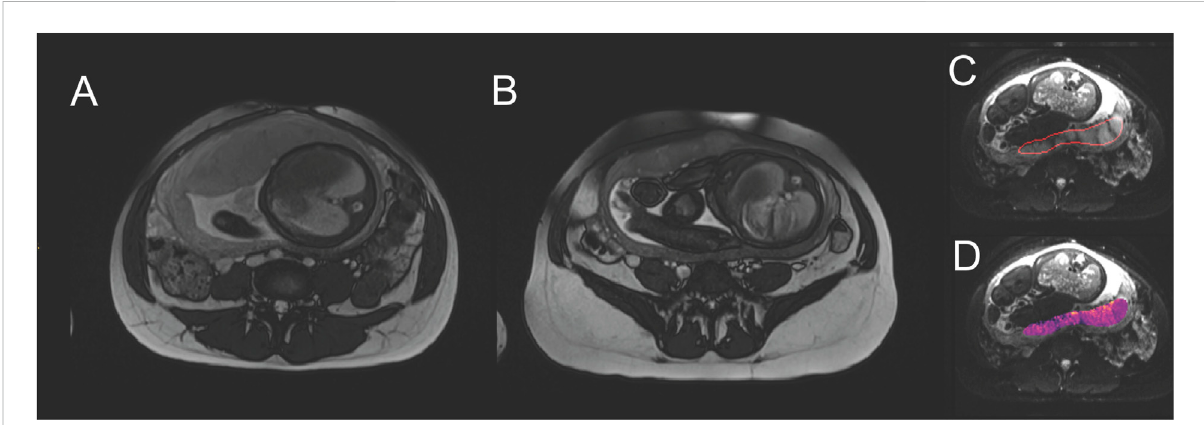
FIGURE 2 Example of placental MRI modalities. Comparing central slices through the placenta, (A) is a normal pregnancy (fetal abdominal diameter 96.5 mm) at 37 weeks gestation, with placental thickness of 41.2 mm. (B) is FGR (fetal abdominal diameter 79.2 mm, birthweight 1.4 centile) at 37 weeks gestation, with placental thickness of 21.8 mm. Placentae in FGR pregnancies are typically described as smaller and appearing darker and more heterogenous in MRI. (C) shows identi fi cation of a placental region of interest. (D) shows a parameter map of apparent diffusion coef fi cient, a parameter that relates to blood movement, and is typically extracted from MRI